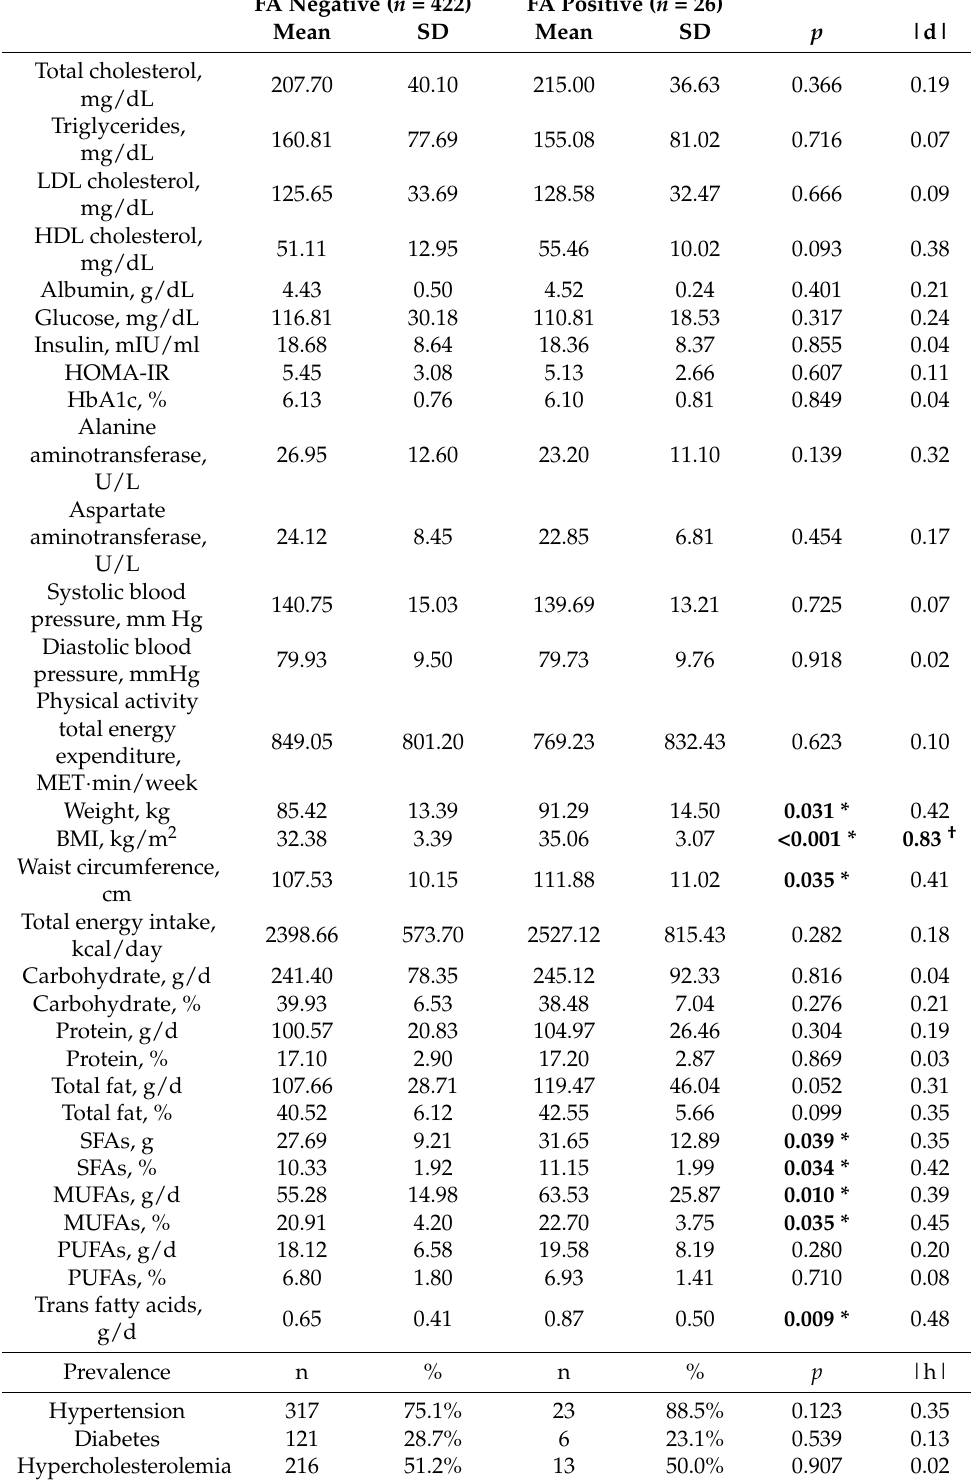
Table 2. Comparison of metabolic and dietary